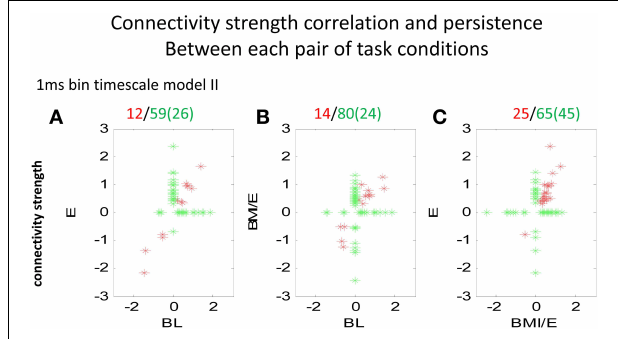
FIGURE 5 | Comparison of connectivity strengths between two conditions modeled at the 1ms binned timescale. Each point marker in the figure denotes a significant parameter and connectivity strength from a pair of neurons, related between two conditions ( A BL vs. E, B BL vs. BMI/E, and C E vs. BMI/E). The red markers denote that the connection between the neurons was significantly different from zero under both the two tested conditions, while the green marker denotes the connectivity of the neurons was only significantly different from zero under one condition (BL, E or BMI/E). The numbers in parentheses indicate number of cells on abscissa. Some of the network connectivity estimated with the GLM models shifted drastically, and much connectivity was unique to a given condition. However, there were also connections that persisted across conditions (red). These persistent connection strengths clearly also correlated. There were more connections in common between E and BMI/E in C , than in either A or in B when these were correlated to BL. Abbrevations: BL, baseline; E, elastic load; BMI/E, brain machine interface and elastic